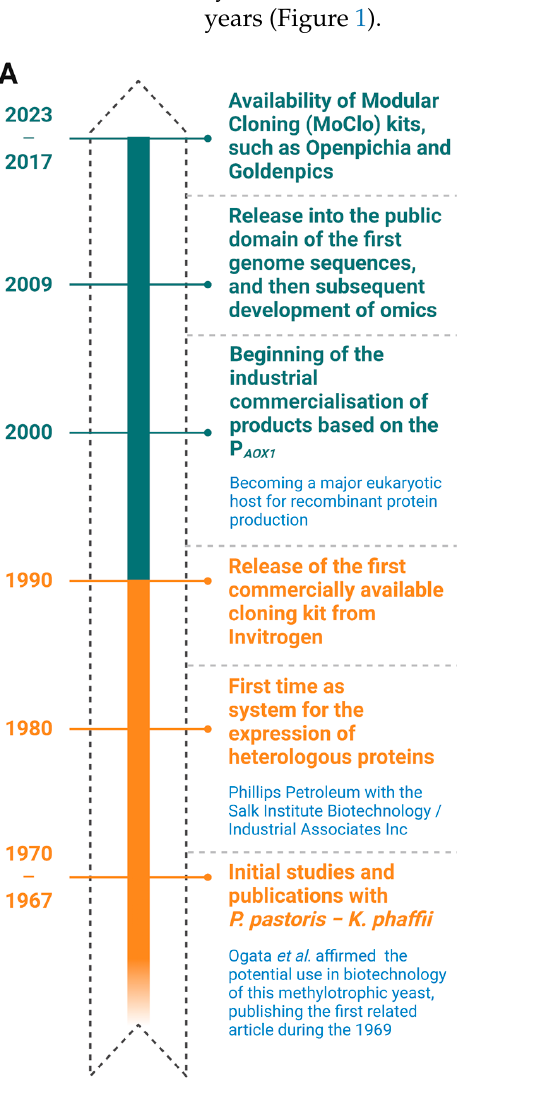
Figure 1. Timeline of achievements for K. phaffii biotechnology during the last fifty-five years ( A ) and the principal steps (e.g., designing, building, testing, and learning) plus the main technologies for recombinant protein production (e.g., protein purification, and characterization systems) ( B ).